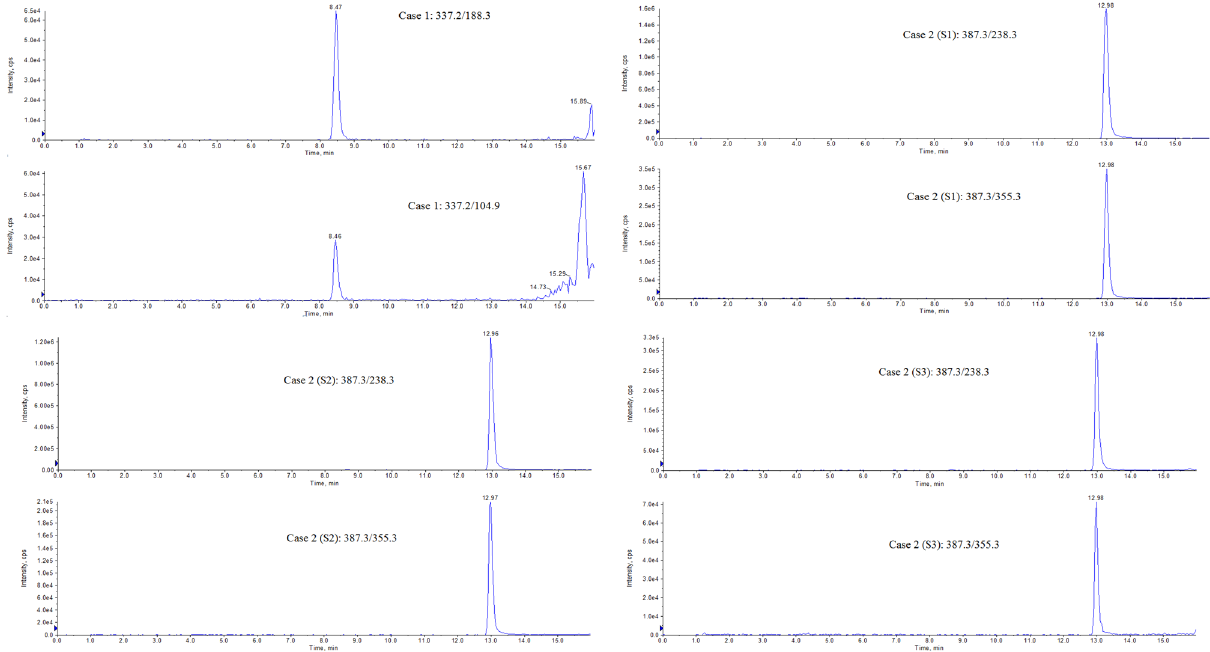
Figure 3. Chromatograms of two MRM transition in the authentic